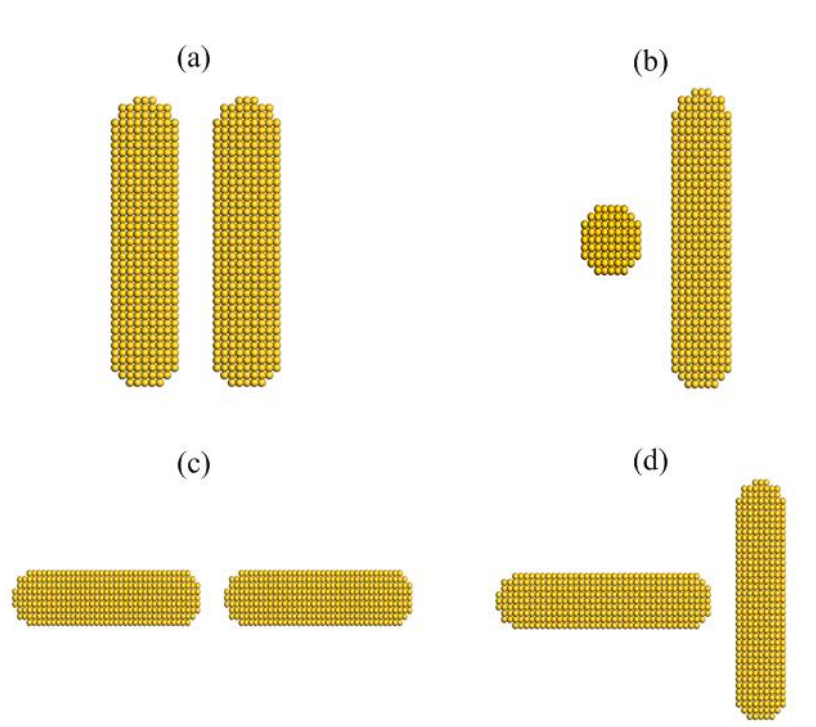
Figure 8. Typical configurations of a pairwise AuNRs with a diameter of 2 nm and aspect ratio of 4: ( a ) side-by-side, ( b ) crossed, ( c ) head-to-head and ( d ) head-to-side.